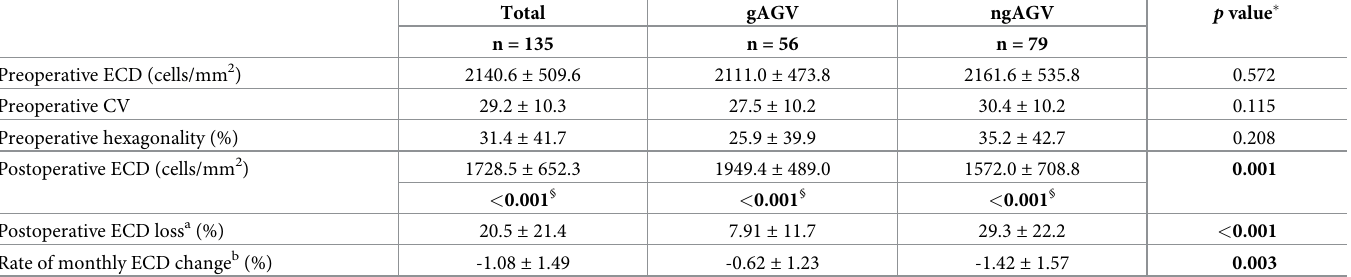
Table 3. Comparisons of preoperative and postoperative corneal endothelial cell measurements between the guided and non-guided Ahmed glaucoma valve implantation groups.